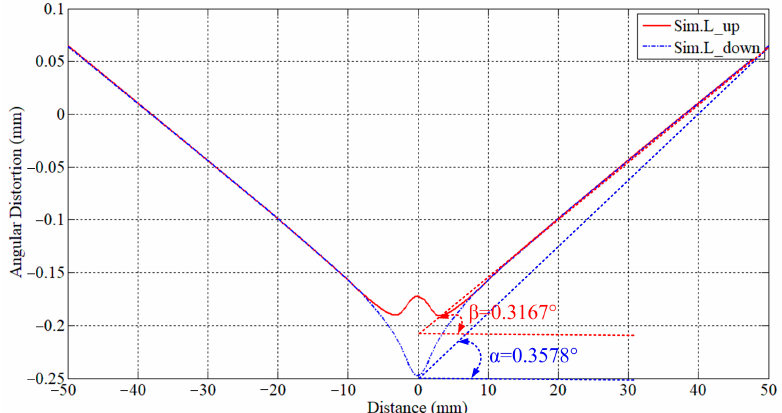
Figure 12. Angular distortion along L1.